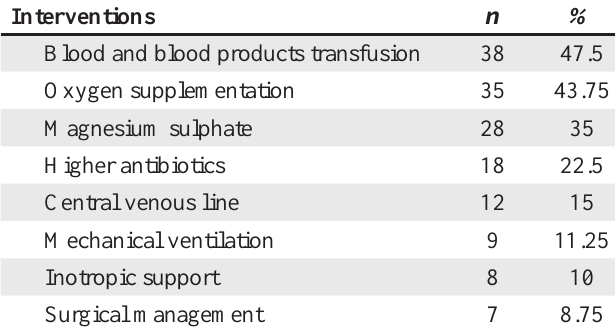
Table 3 : Interventions in ICU obstetric admissions (N = Interventions